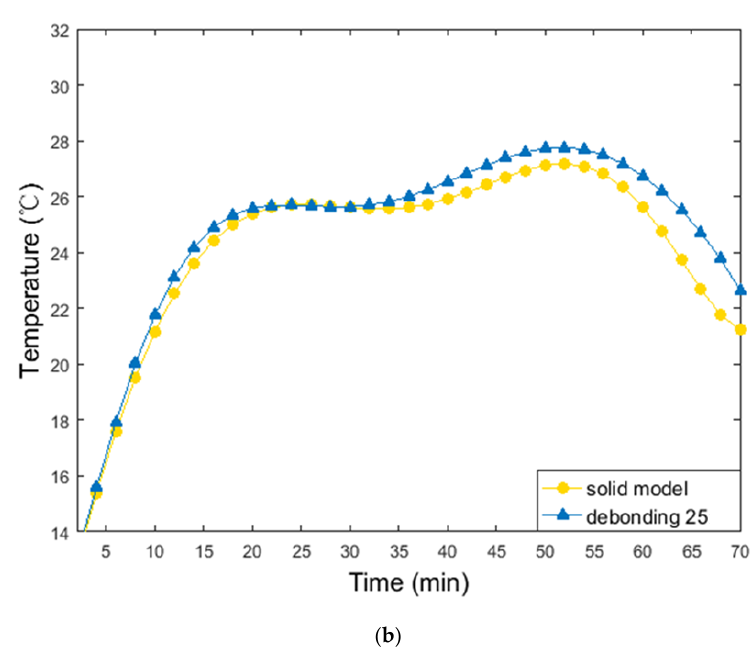
Figure 17. Temperature history of ( a ) point 2 and ( b ) point 3.